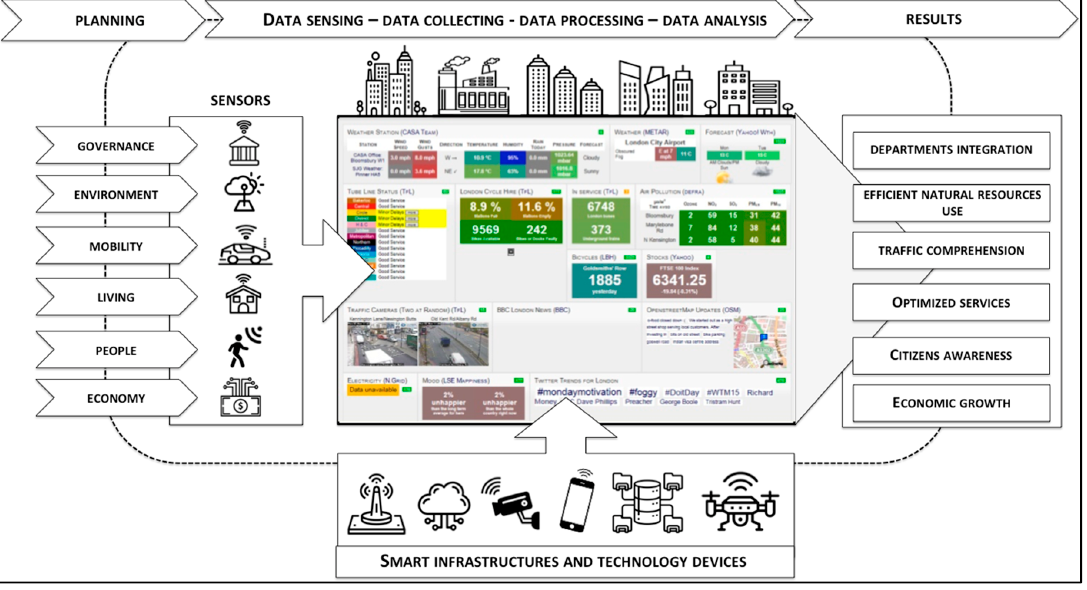
Figure 2. Sensor city framework (source: authors).